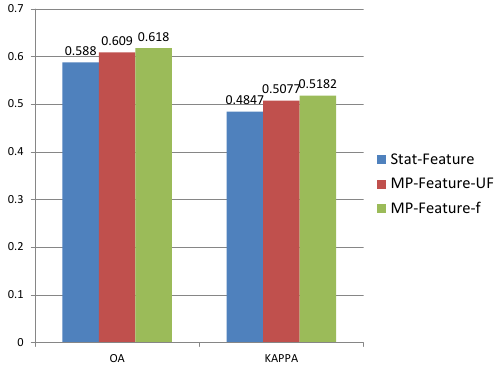
Figure 8. Classification evaluation using OA and Kappa coefficient as the evaluation